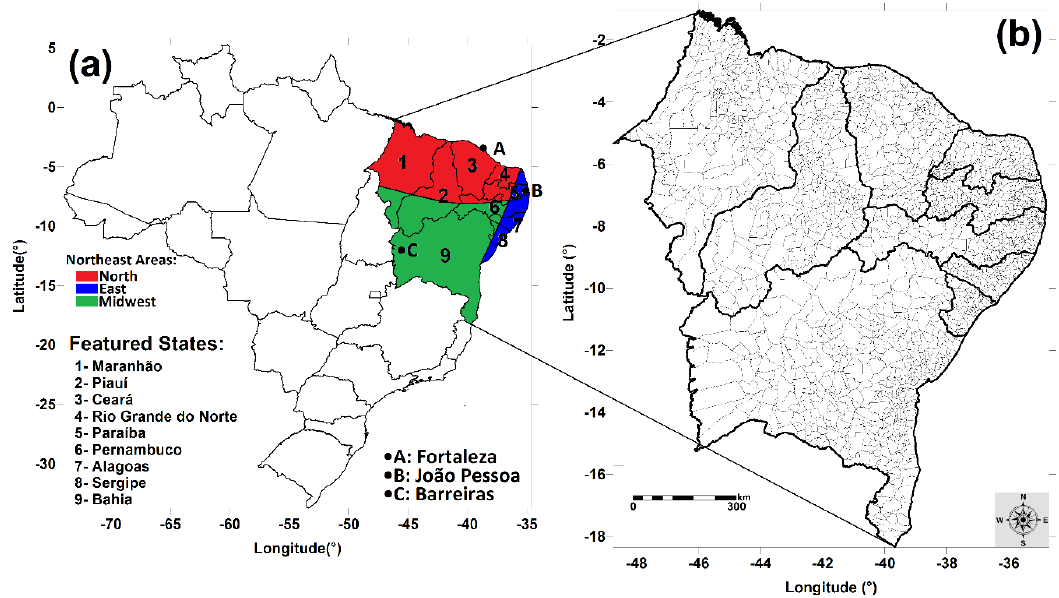
Figure 1. ( a ) Map of Brazil highlighting the northeast region in gray, with numbered and identified states and rainfall homogeneous areas: North (red), East (blue), and Midwest (green); ( b ) Geographic distribution of the 1794 NEB municipalities.